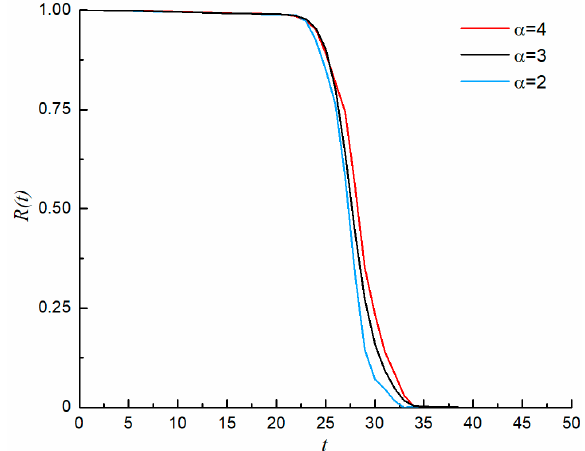
Figure 7. Reliability curves with varying shape coefficients of the gamma process.